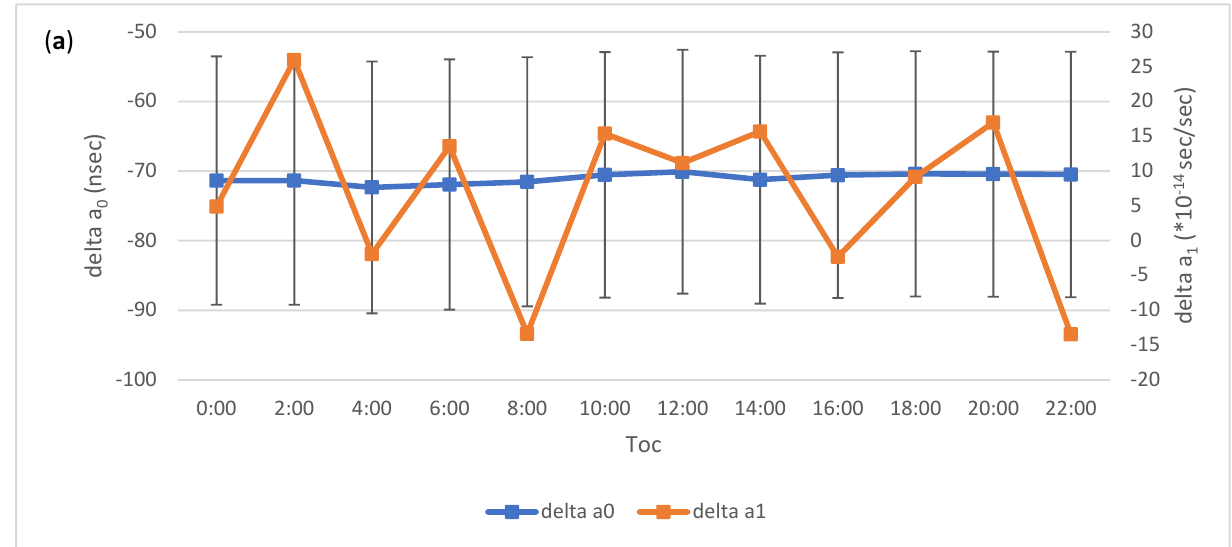
Figure 8 . Pre-fit (dots, different colours for different ephemeris blocks) and post fit (diamonds) residuals of ( a ) X, ( b ) Y, ( c ) Z, and ( d ) T for C12. Post-fits of the time offset T (diamonds) are plotted on the right y -axis.